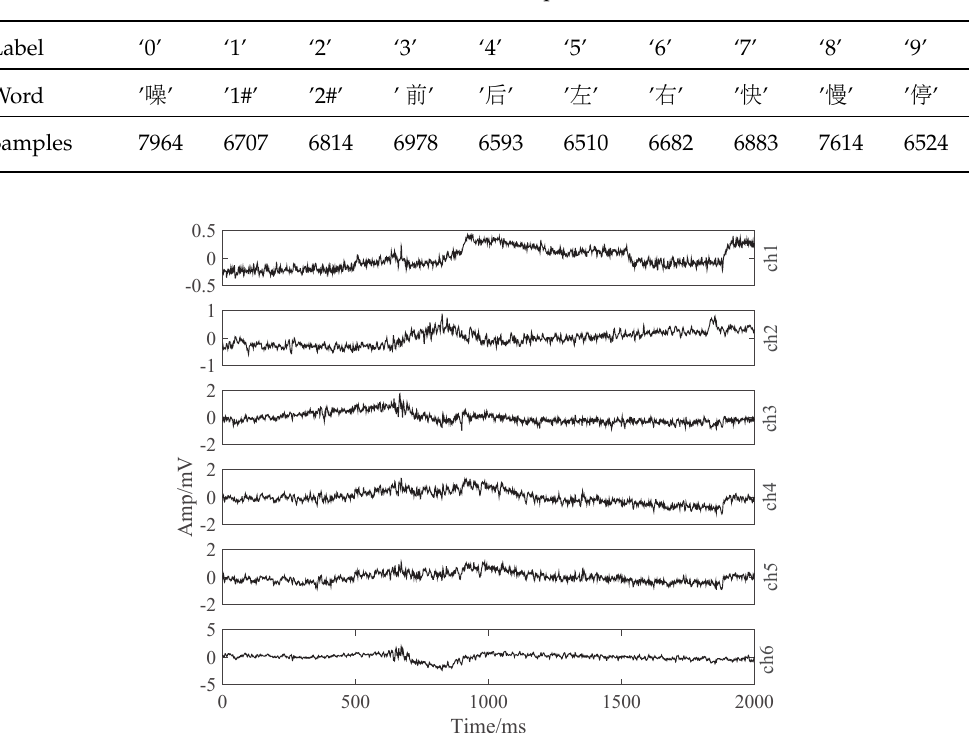
Figure 2. An example of six-channel surface electromyography (sEMG) when imagining to speak ‘decelerate’ in